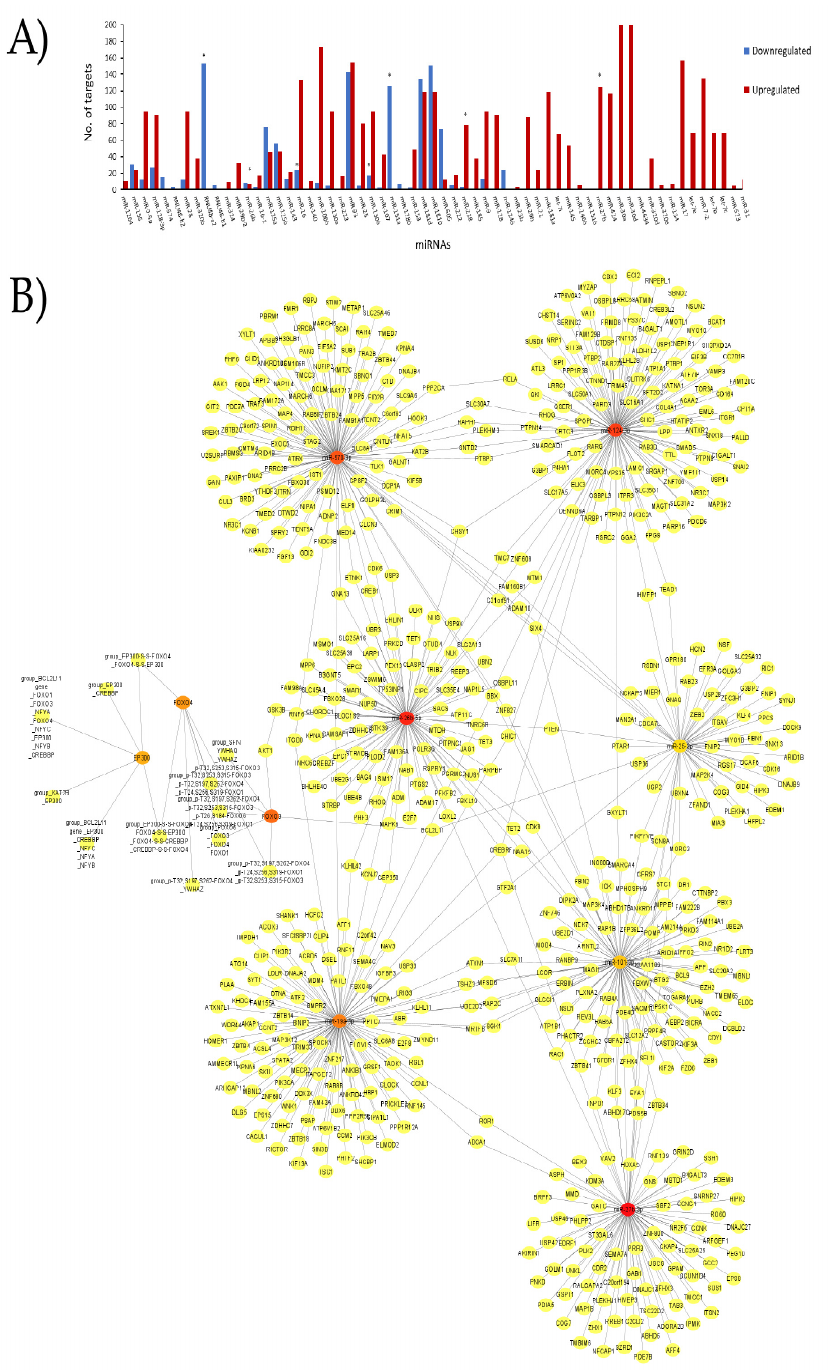
Figure 4. Analysis of miRNAs involved in AIS and their predicted targets. ( A ) The bar plot shows the number of targetable genes included in the miRNAs curated dataset. Bars colored in red show upregulated genes while bars in blue show downregulated genes. ( B ) The structural network was built with the Cytohubba plug-in for the top 10 most connected nodes (miRNAs and targets), including miR-27b-3p, miR-26b-5p, miR-124-3p, miR-570-3p, FOXO3 , miR-19a-3p, FOXO4 , EP300 , miR-101-3p, and miR-25-3p. Nodes are colored according to the number of degrees and correspond to the most connected genes and miRNAs from the network (B). For a better image resolution, please review the Supplementary Materials (Figure